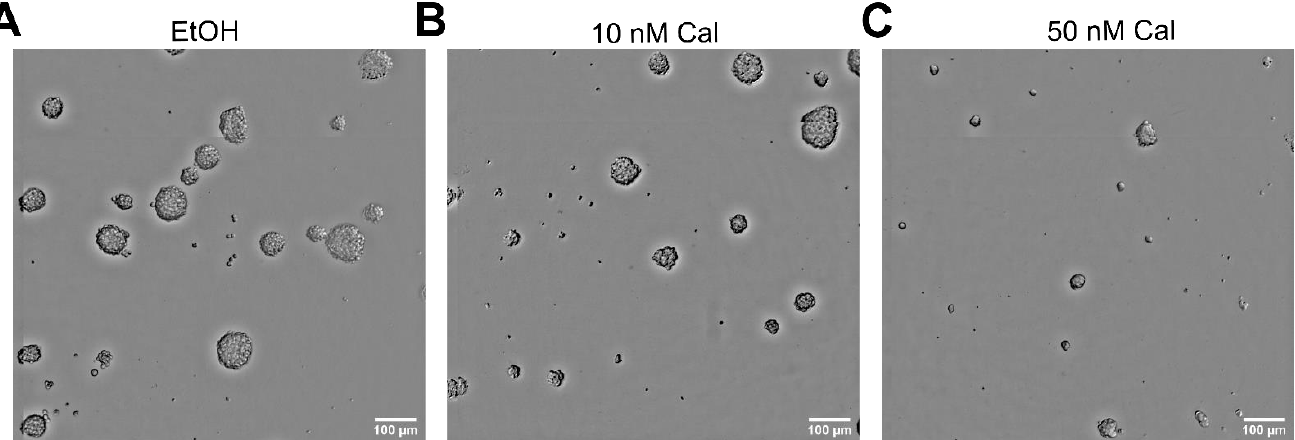
Figure 2. Calcitriol reduces NCH644 sphere size and number. Photomicrographs of NCH644 GSCs 7 days after treatment with ( A ) solvent (ethanol, EtOH), ( B ) 10 nM of calcitriol (Cal) or ( C ) 50 nM of Cal. Pictures were taken with a Tecan Spark plate-reader and images were cropped using FIJI (v1.52p) [33] .